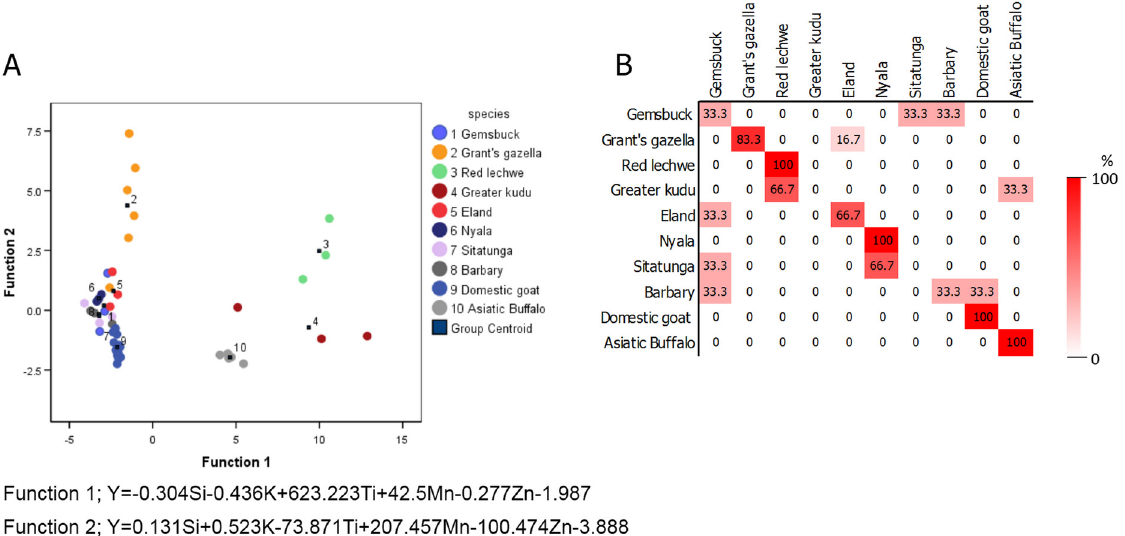
Fig 1. The feasibility of elemental composition in horn for species classification. (A) Canconical discriminant function plots of the elemental composition of horn of different species (B) the classification results by discriminant analysis expressed as a percentage of the correct prediction.